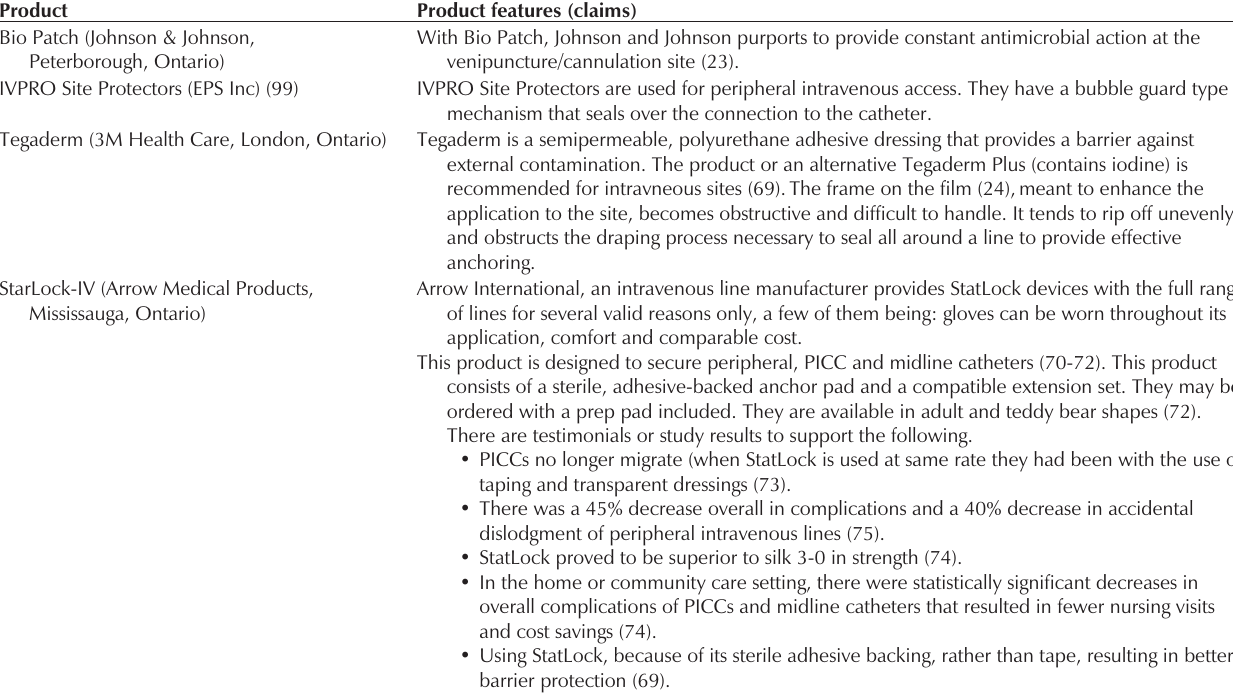
Stabilization of venous access Product Product features